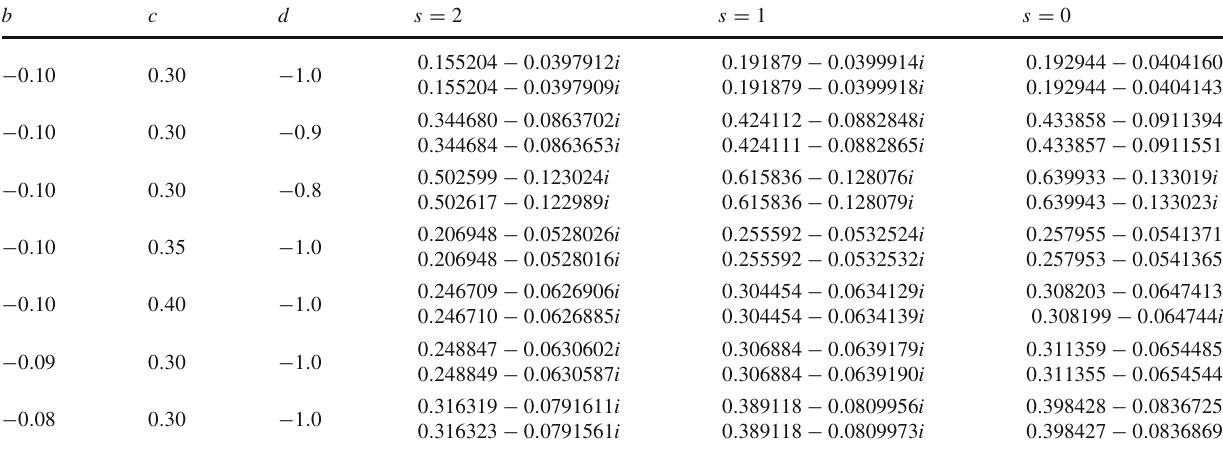
Table 1 The fundamental QNMs for (cid:16) = 2, calculated by using the AIM method (first row) and WKB formula (second row)